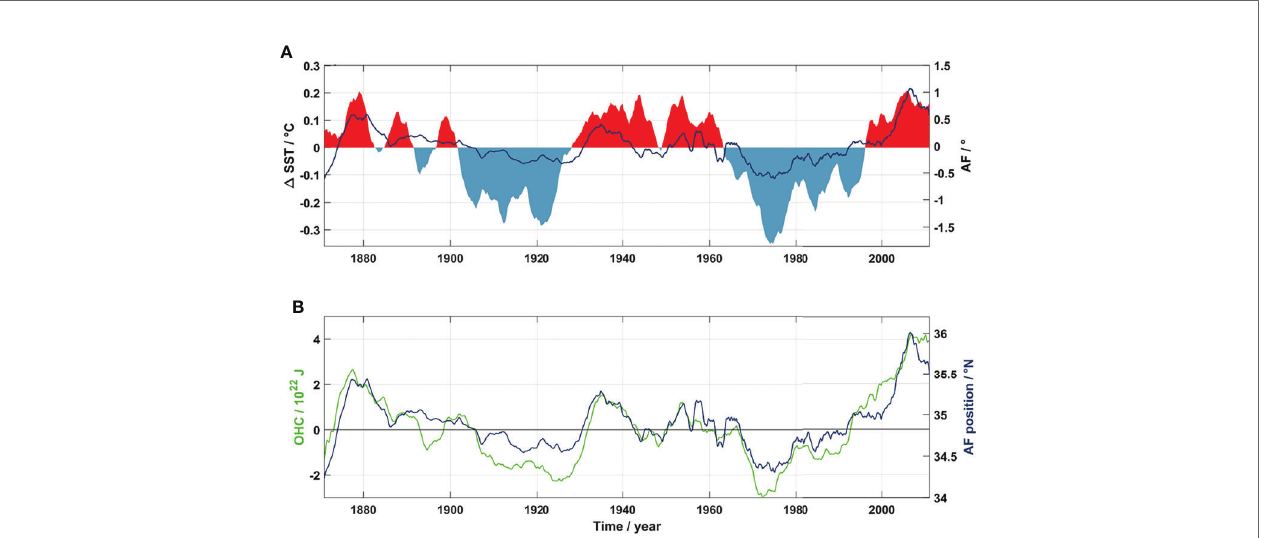
FIGURE 6 | The Azores Front. (A) Monthly detrended Azores Front position (solid dark blue line) superimposedonthe AtlanticMultidecadal Oscillation index (shadowed areas: positive phase in red;negative phase in blue). (B) Monthly Azores Front position (solid dark blue line) and integratedOHC in the upper 400 m (solid green line; details on the OHC calculation are given inDataand Methods).The Azores Front position isan averageof allthe Azores Front positionsbetween 30°Wand 20°W.The monthly detrended time-series was calculatedby removingthe linear trend for the entire period.All time-series are smoothedwith a